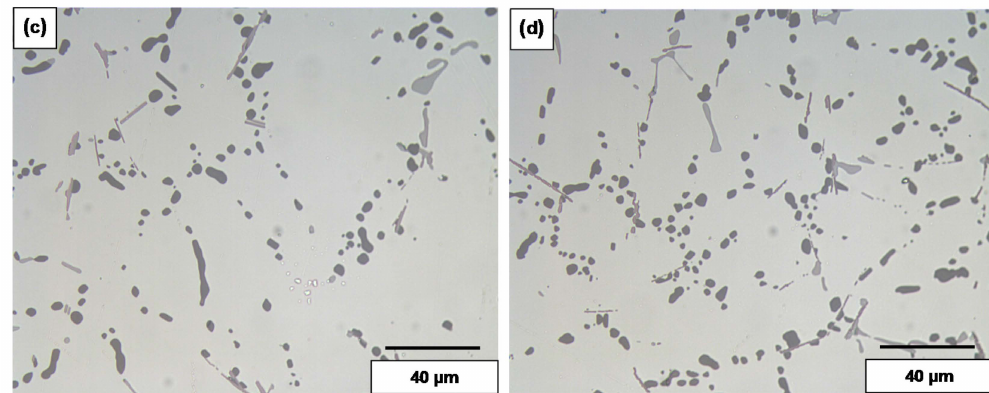
Figure 9. Morphology of eutectic silicon particles observed in the 357 alloys under the following conditions: ( a ) and ( c ) are the high levels of Mg and Fe alloy C3 in the as-cast and solution heat-treated conditions, respectively; ( b ) and ( d ) are Sr-modified C3BS alloy with Be in the as-cast and solution heat-treated conditions, respectively, DAS of 25 µ m; black arrows in ( b ) point to precipitation of β -Al 5 FeSi platelets.